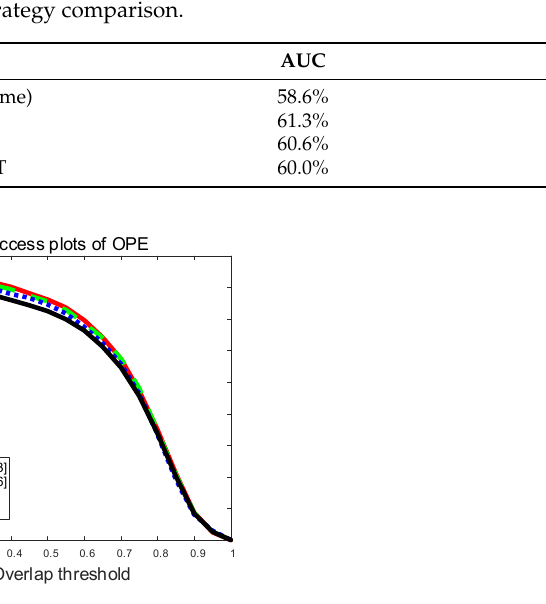
Figure 5. The OTB-2013 benchmark test for the interval update strategy. The effect was obviously improved after adding long-term memory filter. In an occlusion environment, the performance when N S = 3 was not as good as when N S = 5, presumably because of the occlusion time, and the occlusion object is trained as a sample. Table 1. Update strategy comparison.